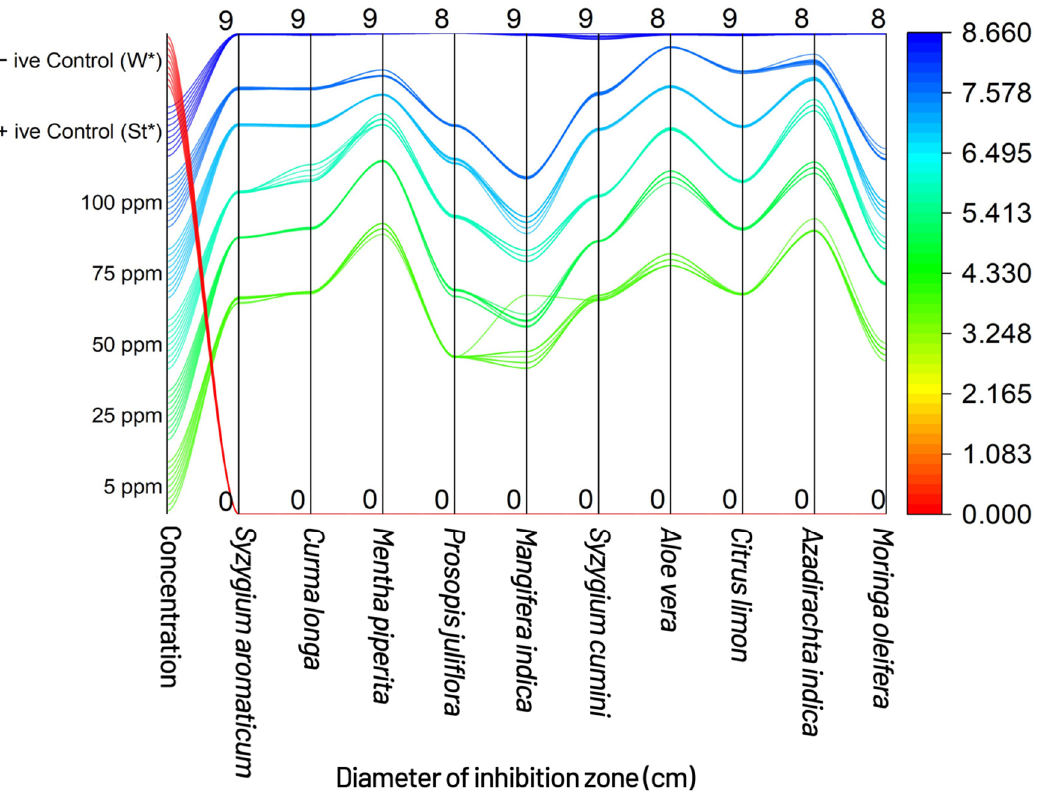
Figure 4. Sankey diagram showing the flow of various concentrations of treatments, communicating various levels of treatment concentrations towards the diameter of the inhibition zone (cm); +ive Control (St*) = Streptomycin, which was used as standard, and similarly, –ive Control (W*) = water, which was used to compare the results with aqueous extracts (botanicals) and streptomycin.